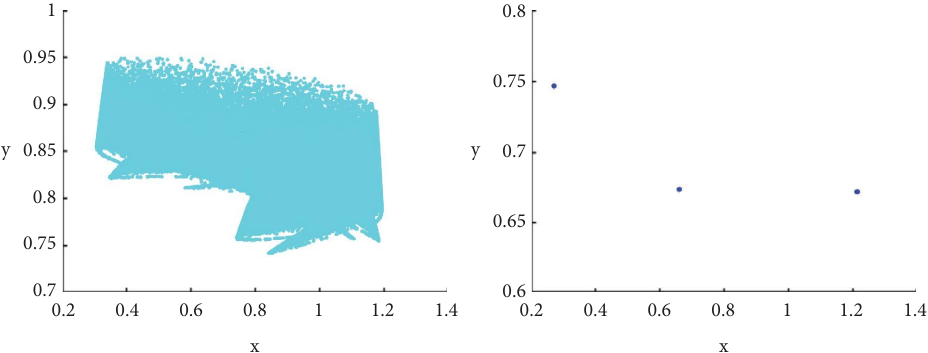
Figure 13: Phase portraits for period-3 and chaos orbits.